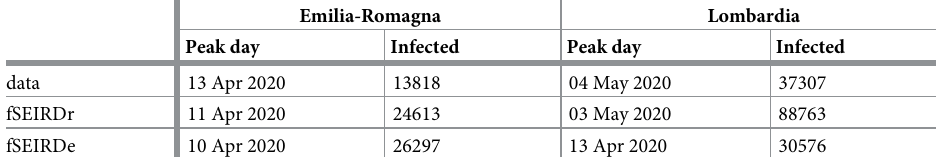
Table 3. Infected peak days.